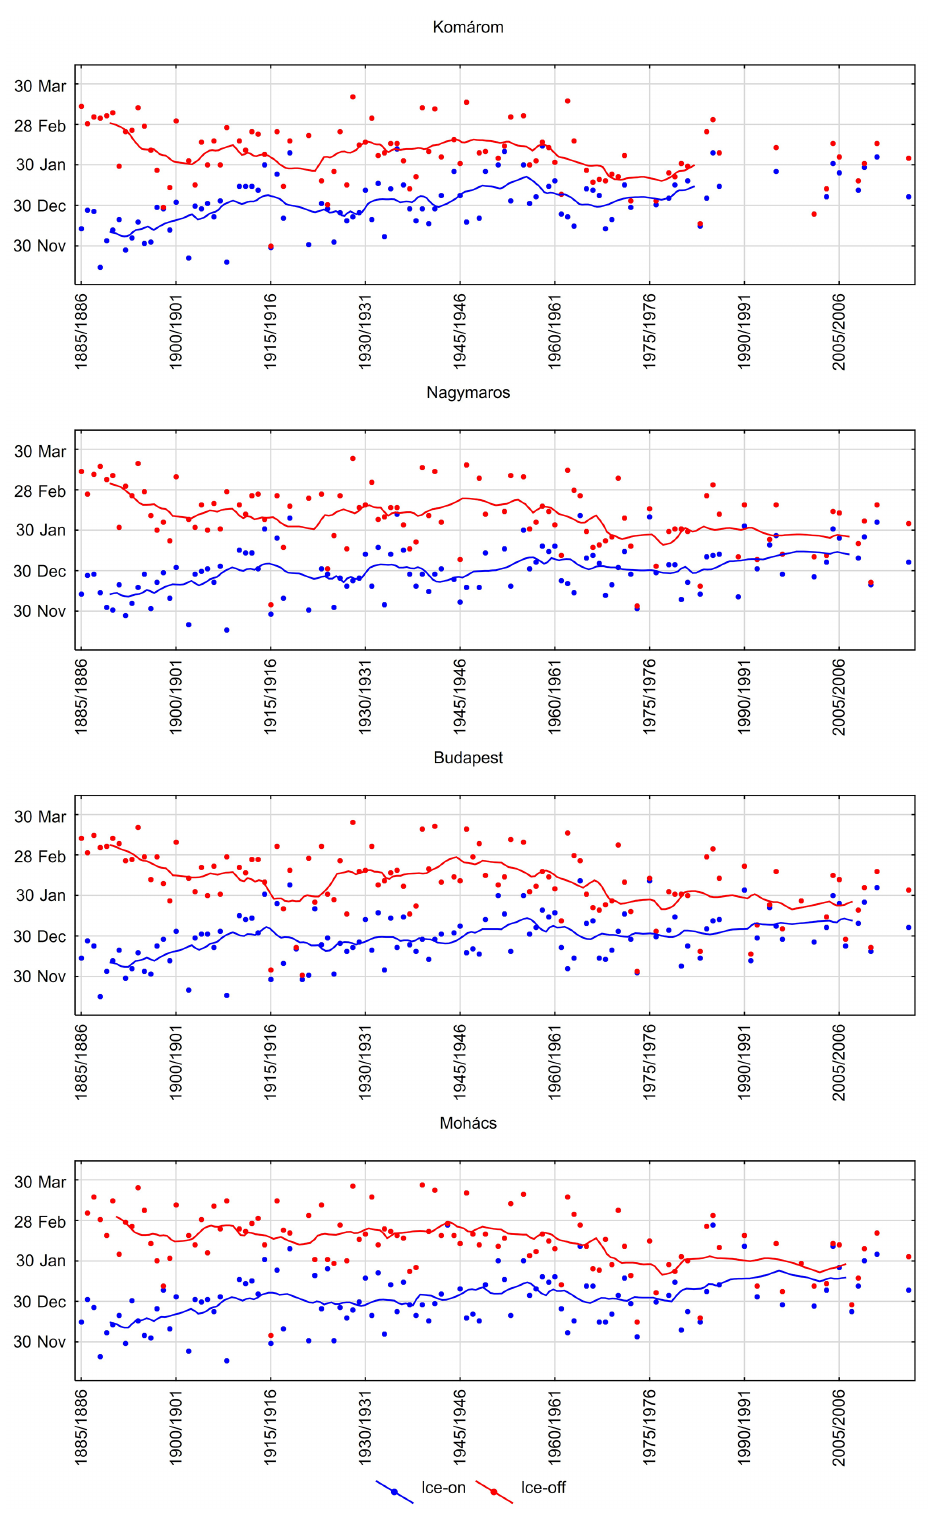
Figure 4. Variations in the dates of ice-on and ice-off on the River Danube from 1885 to 2017. (Blue and red curves are 10-year moving